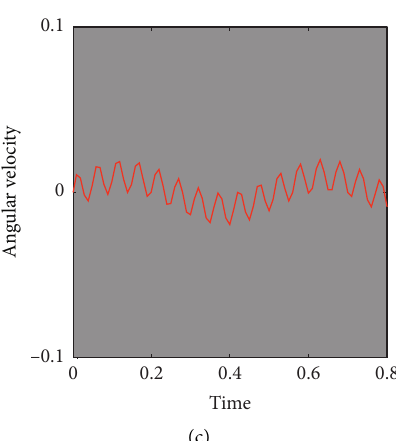
Figure 8: Sensor tag data acquisition device collects data: (a) Z -axis angular velocity; (b) Y -axis angular velocity; (c) X -axis angular velocity.